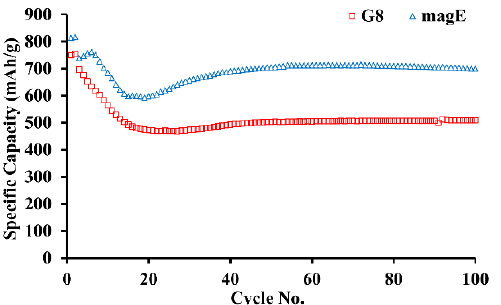
Figure 4. Cycling performance of Si composite anode prepared with CGP-G8 and magE graphite materials.